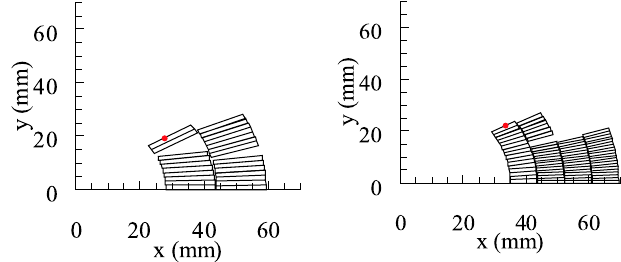
FIG. 8. (Color) Coil layouts (one eight shown in the plot) of the LHC MQ (left) and MQY (right).